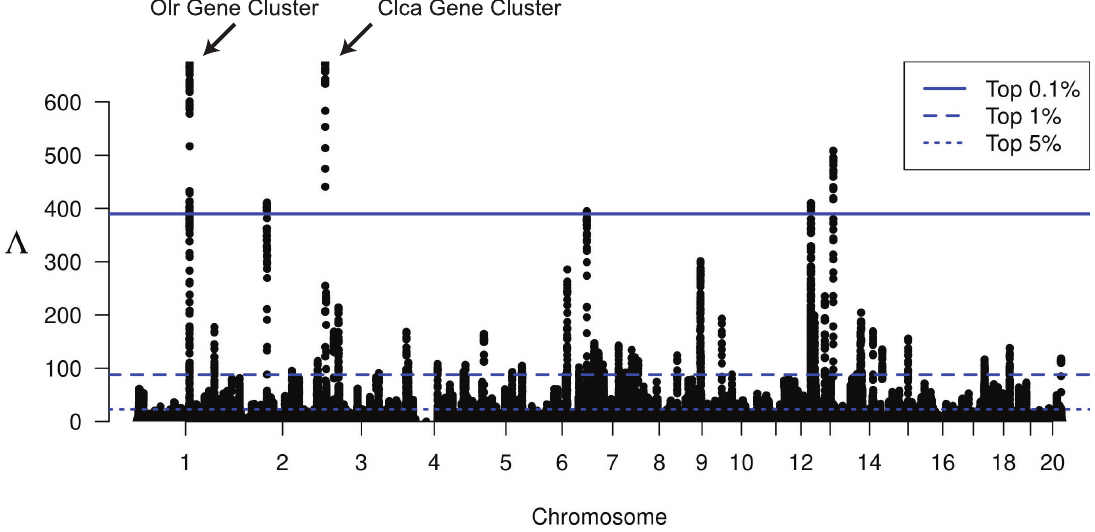
Fig 7. Manhattan plot of Λ -statistics for the New York City rat population. Each point represents a single 201-SNP window along the genome. Horizontal lines represent the top 5%, top 1%, and top 0.1% observed Λ statistic across all windows in the genome.